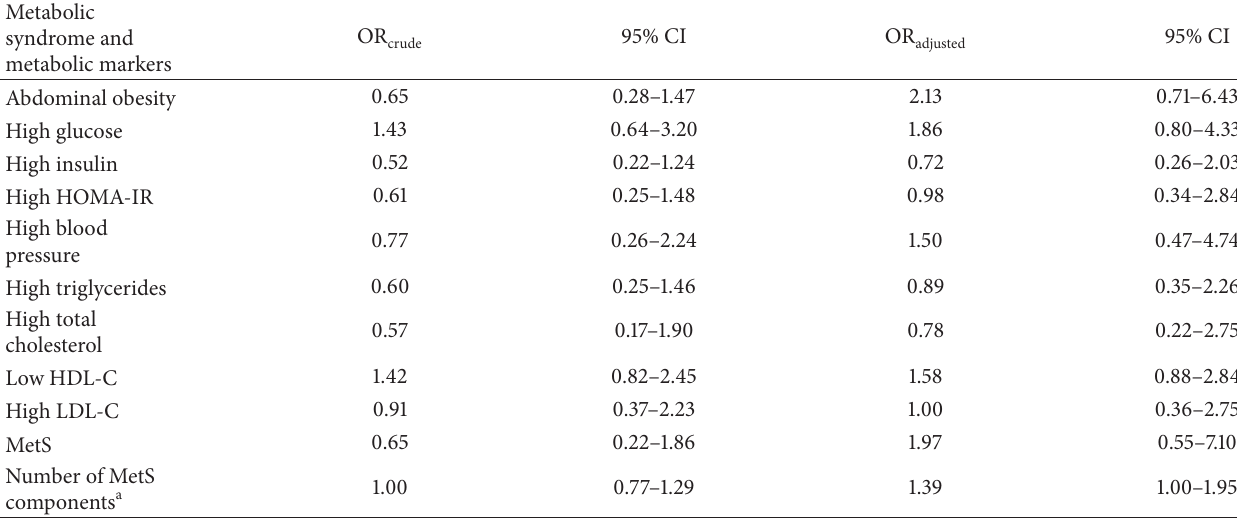
Table 3: Crude and adjusted logistic regression analysis between elevated urine albumin concentration and metabolic syndrome and metabolic markers.